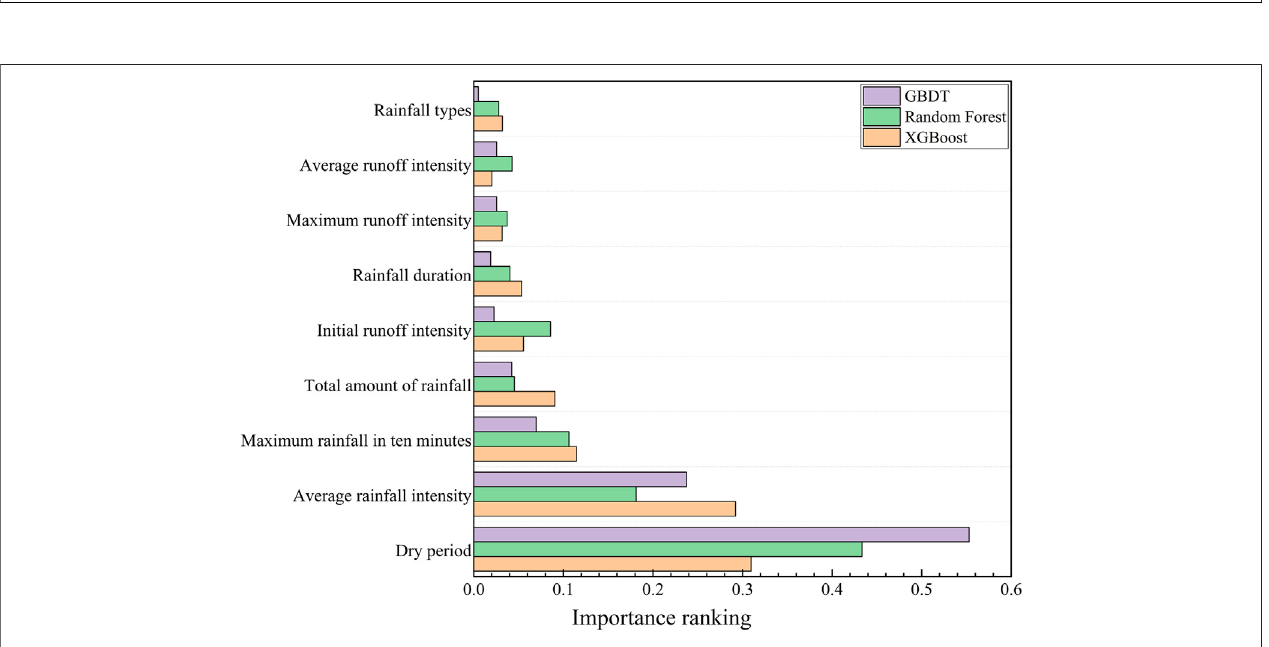
FIGURE 7 | Importance rankings of different rainfall characteristics in terms of their effect on EMC based on GBDT, RF, and XGBoost algorithms.